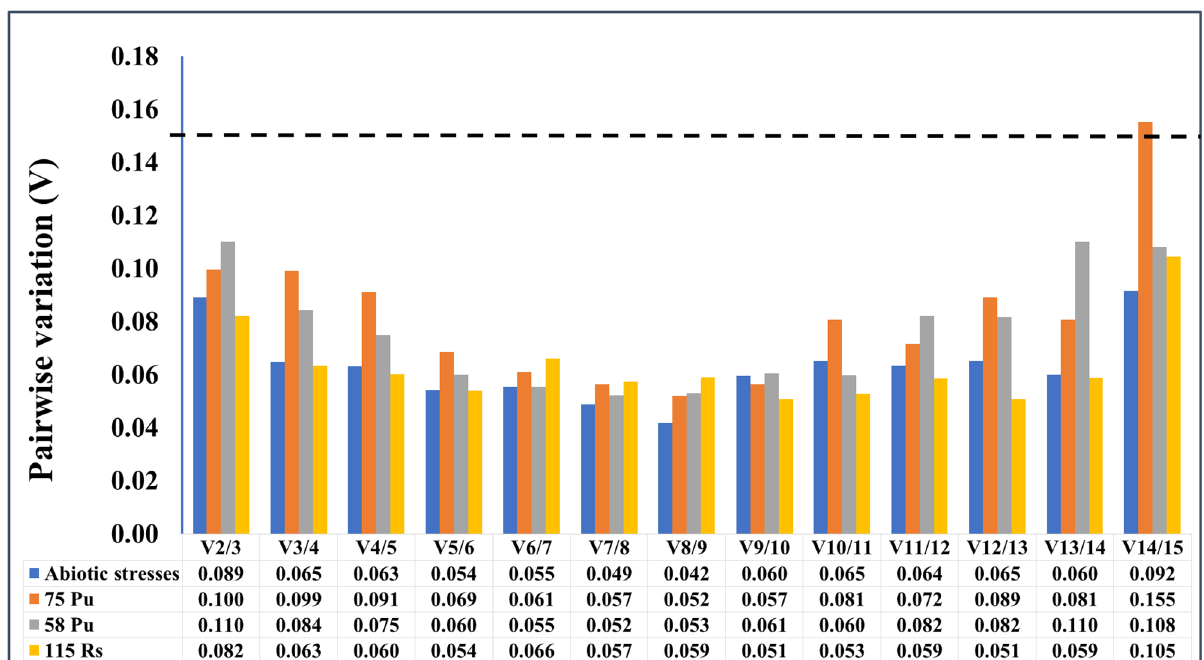
Fig 3. Determination of the optimal number of referencegenes. The pairwisevariation(Vn/Vn+1) was calculatedbetweenthe normalization factors NFn and NFn+1 by geNorm. If the Vn/Vn+1 value is less than 0.15, there is no need to add an additional gene for